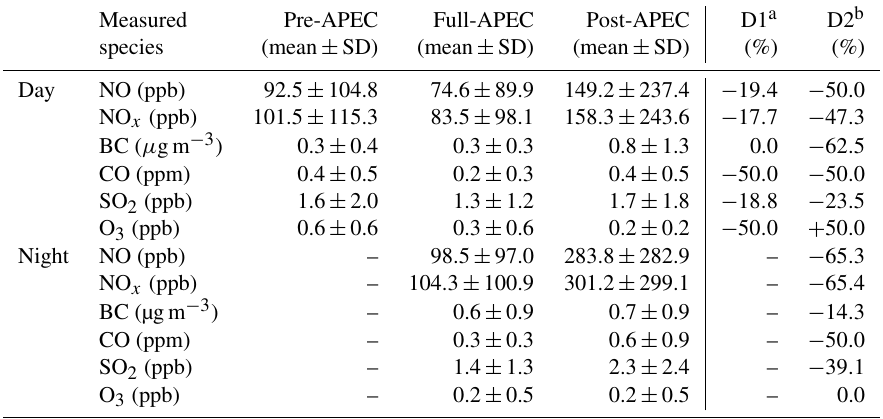
Table 6. The mean on-road emission concentrations (i.e. C veh . ) obtained from WTM and their relative changes between the pre-APEC, full-APEC, and post-APEC periods, divided into daytime and